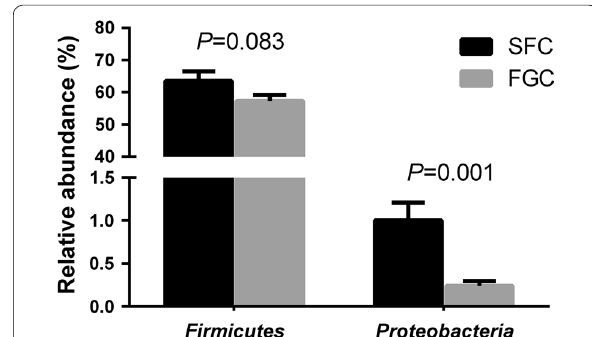
Fig. 3 Comparison of the distribution of rumen bacteria with significant effects at the phylum level for heifers fed steam flaked corn (SFC) or finely ground corn (FGC) diets based on 16S rRNA sequences compared to the SILVA version 128 database. Error bars indicate the standard error of the mean